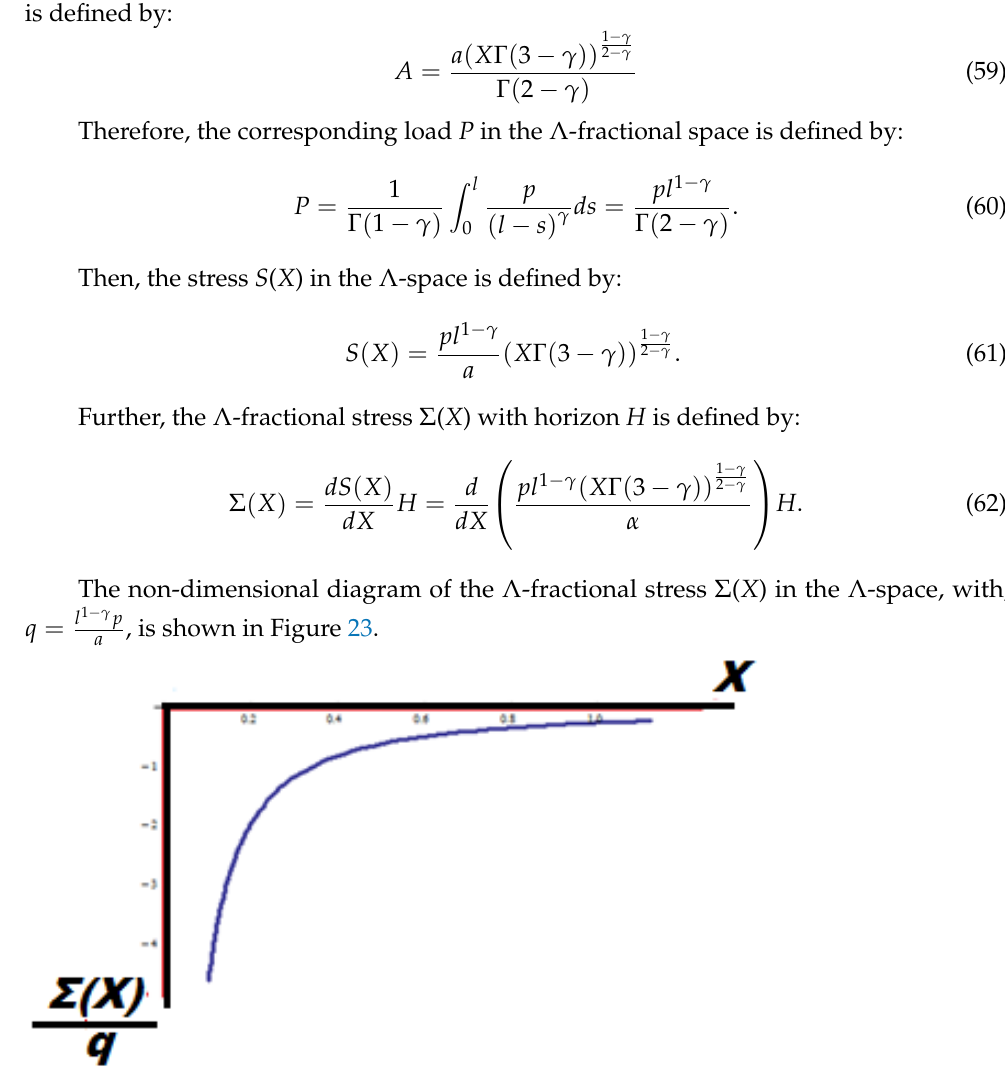
Figure 23. The diagram of the Λ -fractional stress Σ ( X ) in the Λ -space. It is quite strange that the values of the Λ -fractional stress with horizon H in the Λ -space are negative. Likewise, the stress Σ ( x ) in the Λ -space expressed with the variable x of the initial space is: Hence, the true stress Σ ( x ) in the initial space is defined by: